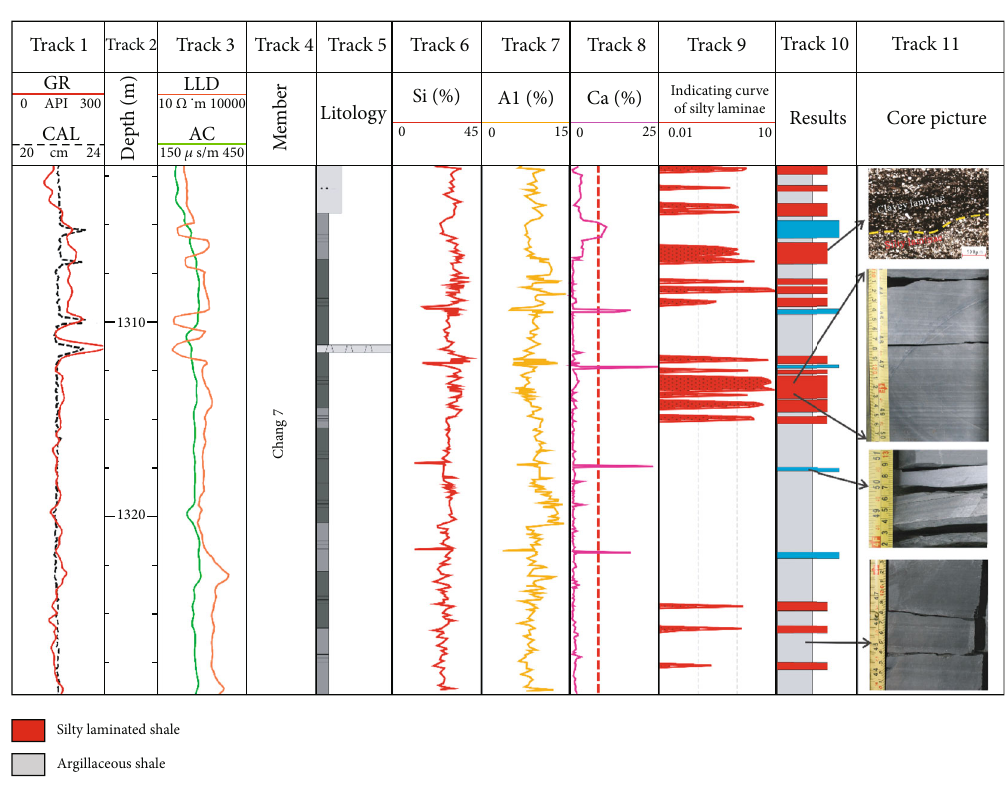
Figure 9: Identi fi cation results of silty laminated shale in Well